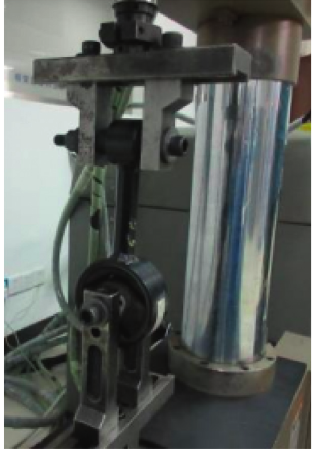
Figure 5: The mount stiffness experiment. Table 2: The static stiffness of each mount in its local coordinate system (N/mm).